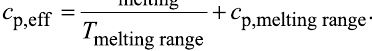
materials. The stored heat is used for both melting and heating of the salt. Hence the temperature rise is lower than by a sensible storage material with the same specific heat